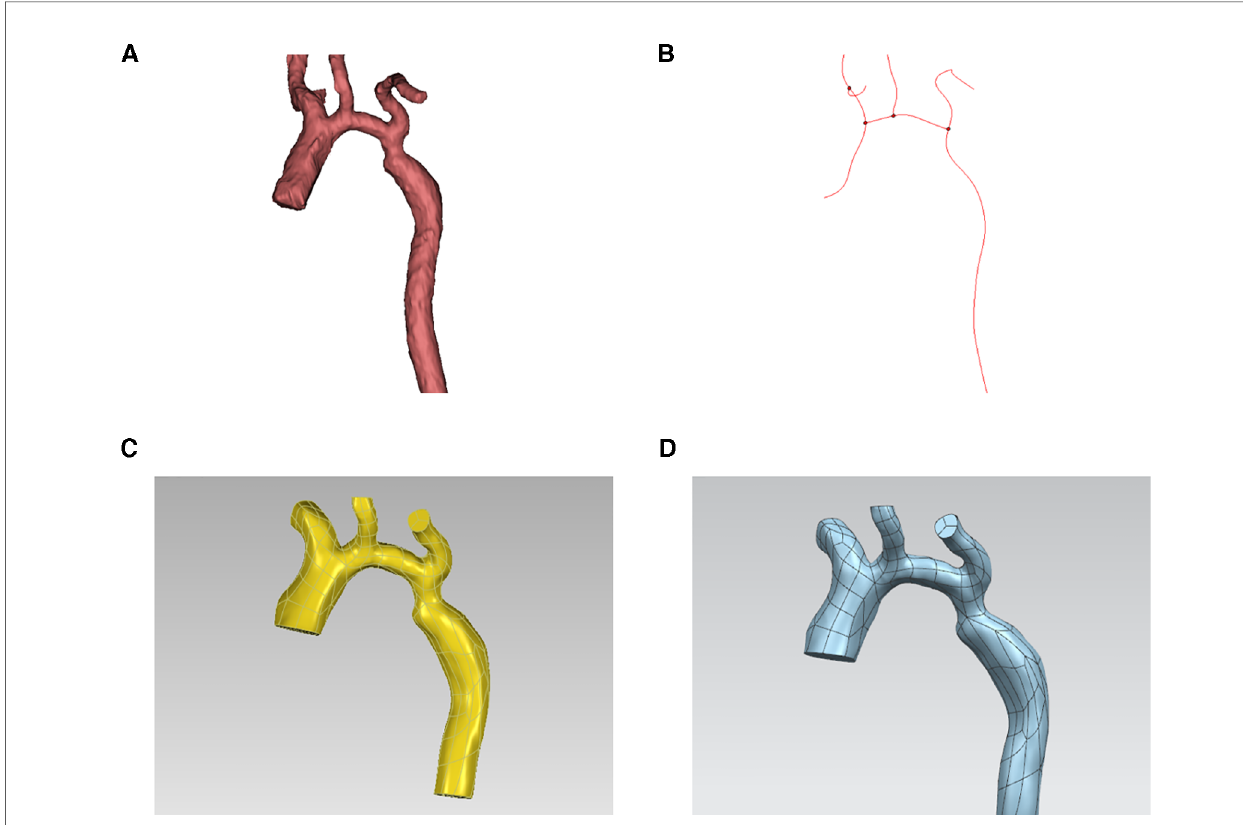
FIGURE 2 Acquisition of image data. ( A ) 3D (three-dimensional) aortic image after accurate reconstruction with mimics software. ( B ) Center line. ( C ) 3D aortic images after smoothing and surfacing process. ( D ) Final